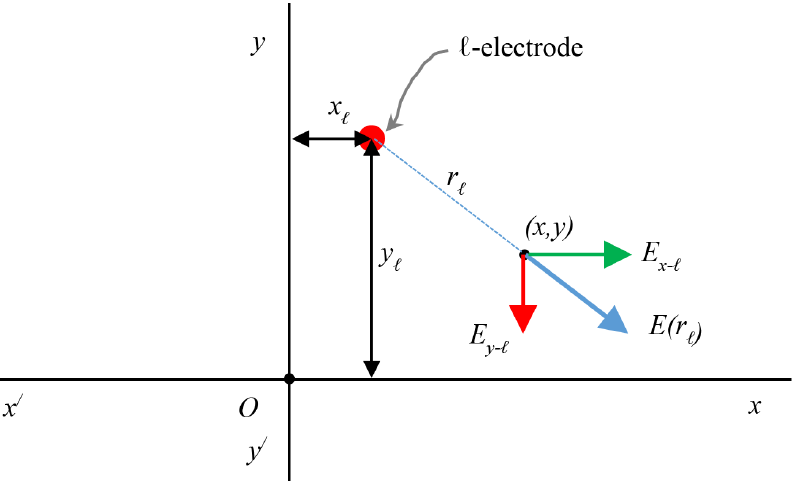
Figure 9. Basic principle of electric field strength analysis of an electrode in xOx’ and yOy’